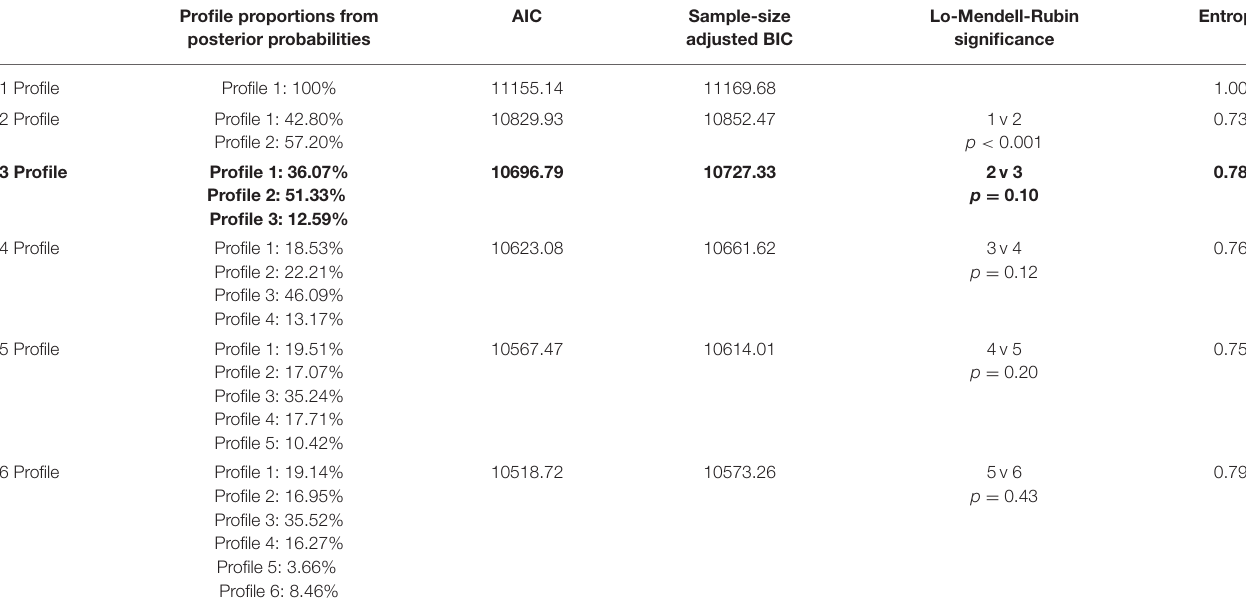
TABLE 4 | Latent profile model fit statistics.